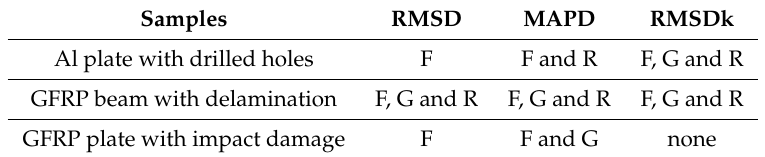
Table 2. Comparative performance study of G, R and F variable for Al, GFRP beam and GFRP plate. Samples RMSD MAPD RMSDk Al plate with drilled holes F F and R F, G and R GFRP beam with delamination F, G and R F, G and R F, G and R GFRP plate with impact damage F F and G